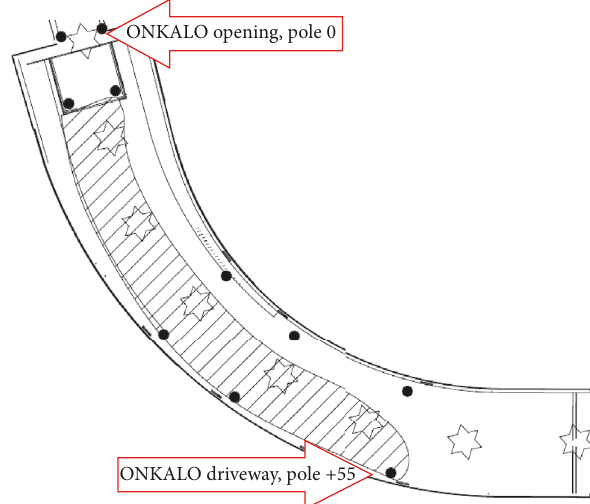
Figure 17: Antenna 1 front reading